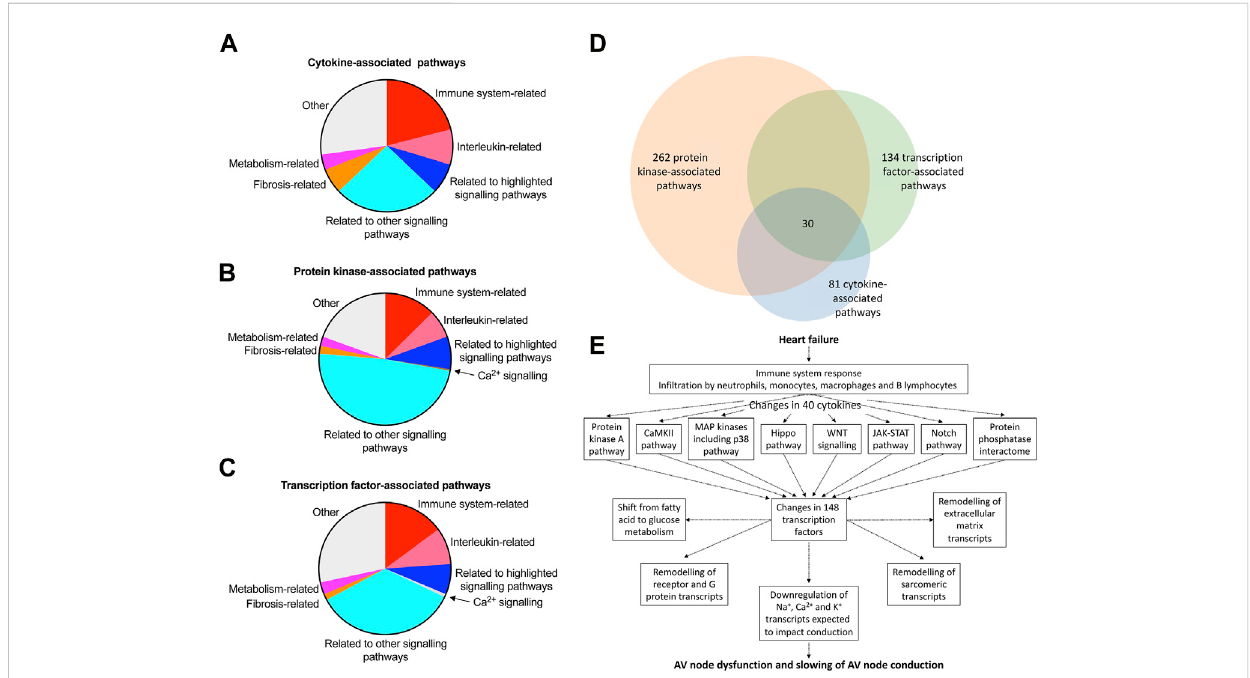
FIGURE 8 Pathways involved in AV node dysfunction in HF. (A – C) , summary of canonical pathways (identi fi ed by Ingenuity Pathway Analysis) associated with the cytokines (A) , protein kinases (B) and transcription factors (C) changing signi fi cantly in the AV node in HF. Details of the pathways are given in the Supplementary File, Canonical pathways. xlsx. 81, 262 and 134 pathways associated with the cytokines, protein kinases and transcription factors, respectively, were identi fi ed in total and the area of the pie chart for each group of pathways re fl ects the number of pathways in each group. (D) , Venn diagram of the pathways associated with the cytokines, protein kinases and transcription factors; there is substantial overlap of the pathways and 30 pathways were common to the cytokines, protein kinases and transcription factors. (E) , schematic diagram showing a potential chain of events in the AV node during HF leading to AV node dysfunction. Although the schema is based on the results of this study, it remains hypothetical. Although unidirectional arrows are drawn, they could be